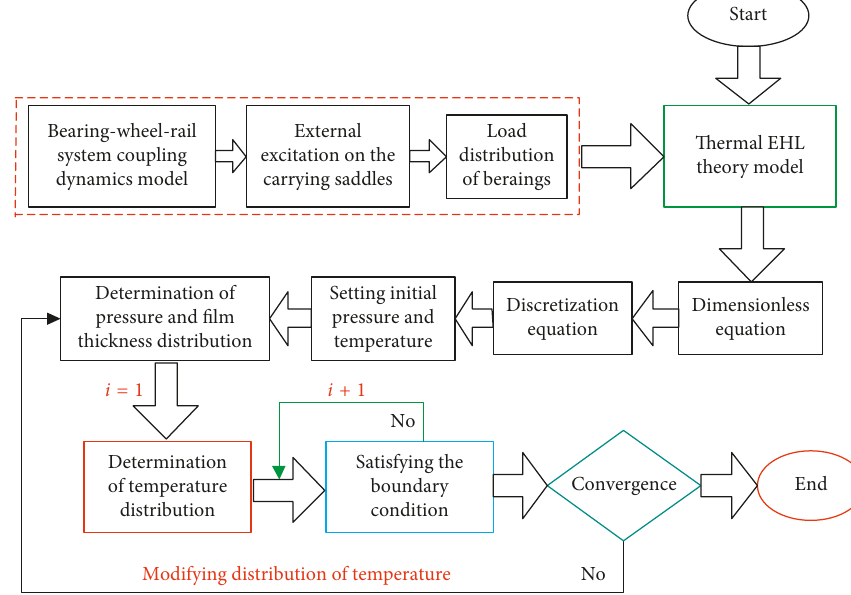
Figure 6: Calculation flowchart of the thermal EHL equation. Table 1: Structural parameters of the axle box bearing and wheelset/track system.